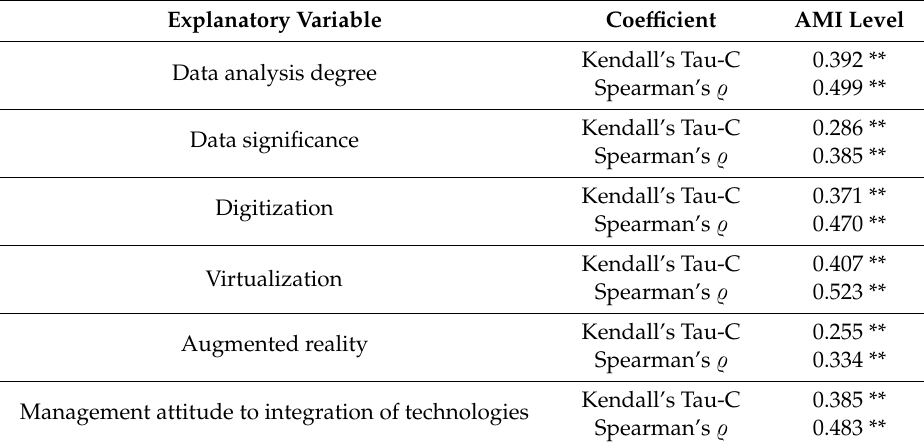
Table 4. Correlation between predictors and the level of ambient intelligence of an